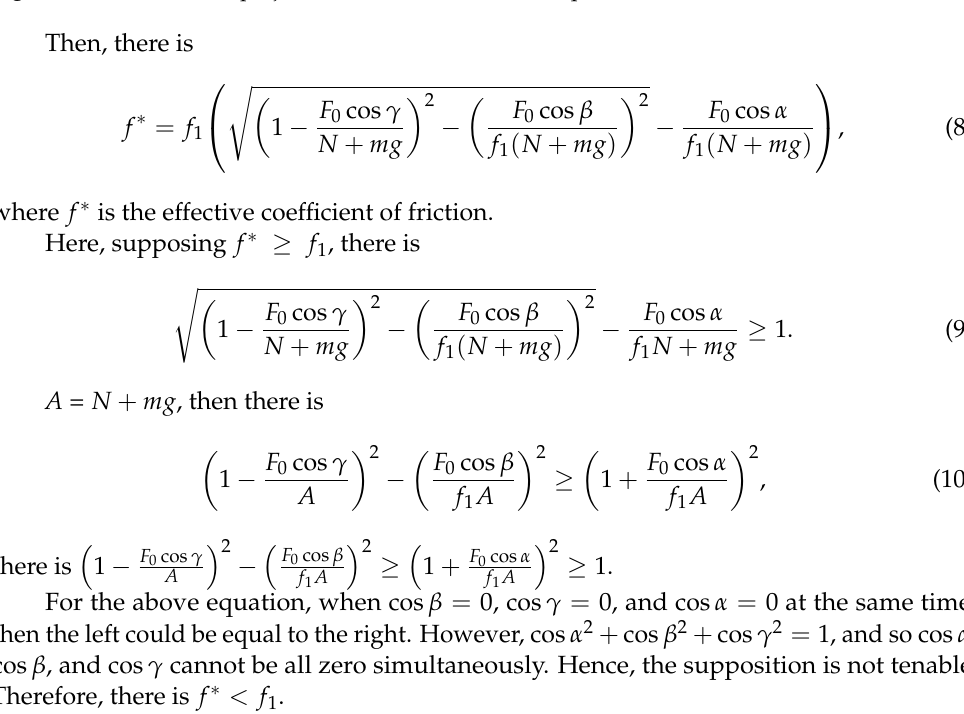
Figure 5. Vibration force projects in the first and the third quadrants.